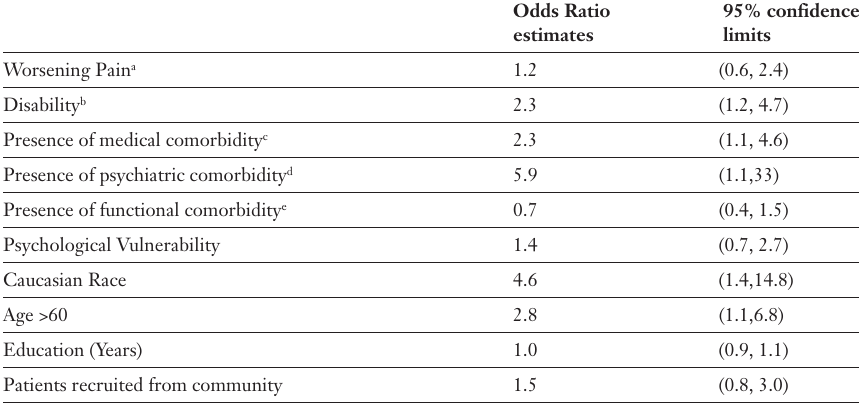
Predictors of high number of physician visits (>12